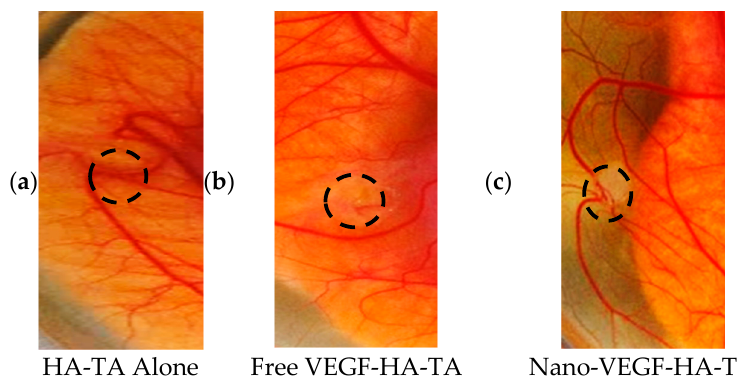
Figure 3. Chick chorioallantoic membrane at day twelve, exposed to ( a ) HA-TA alone, ( b ) free VEGF-HA-TA and ( c ) nano-VEGF-HA-TA. No hyperemia is present in any group. VEGF dose in all cases is 500 ng per 200 µL hydrogel portion. One representative image is shown from each group. Circle indicates hydrogel position. ( n = 5).